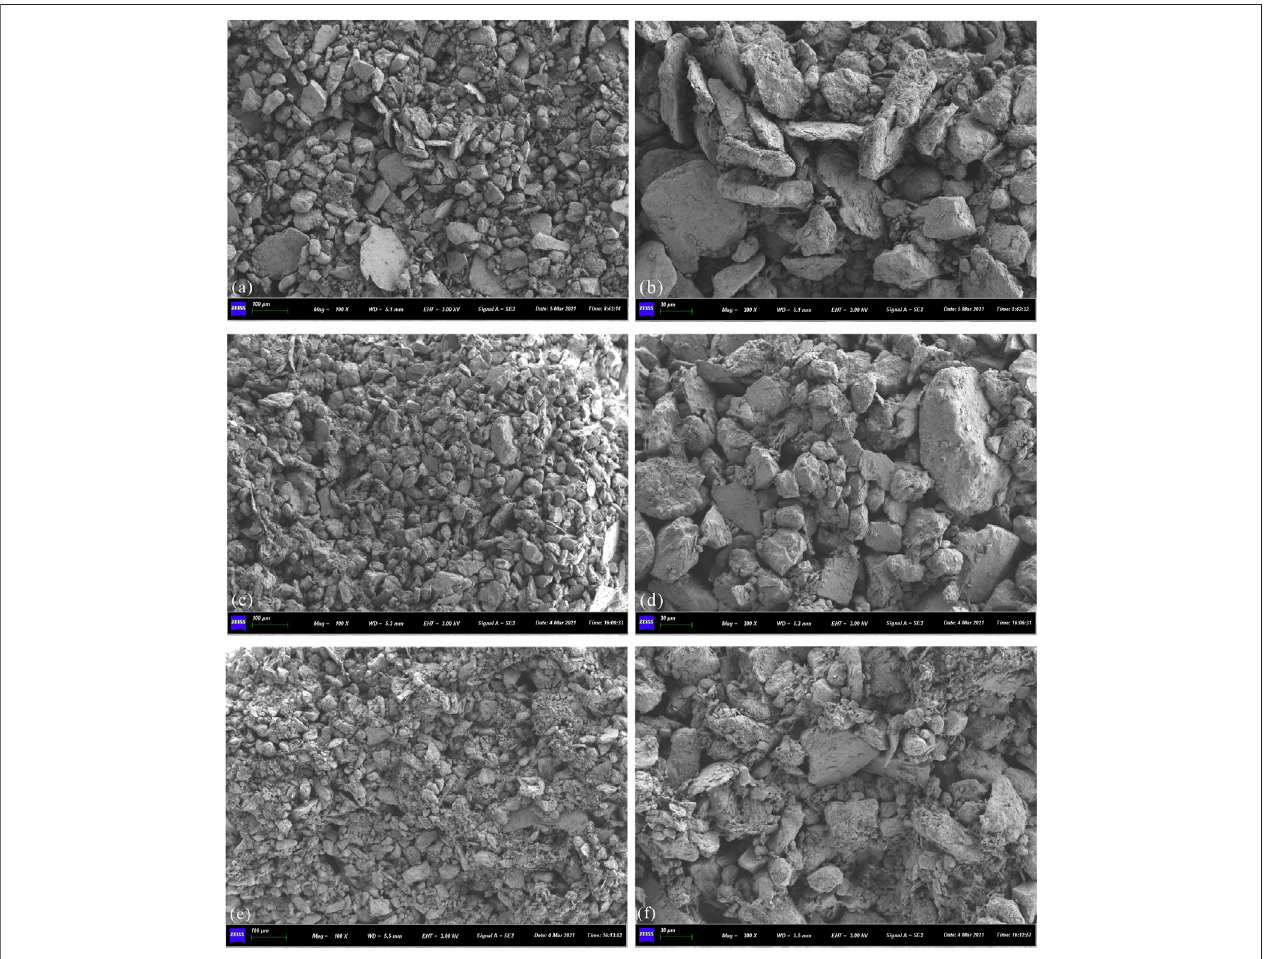
FIGURE 12 | Photomicrographs of intact loess at different initial water contents after compression: (A,B) overall view and detailed view, w 0 = 7.14%; (C,D) overall view and detailed view, w 0 = 18.03%; (E,F) overall view and detailed view, w 0 = 35.02%.